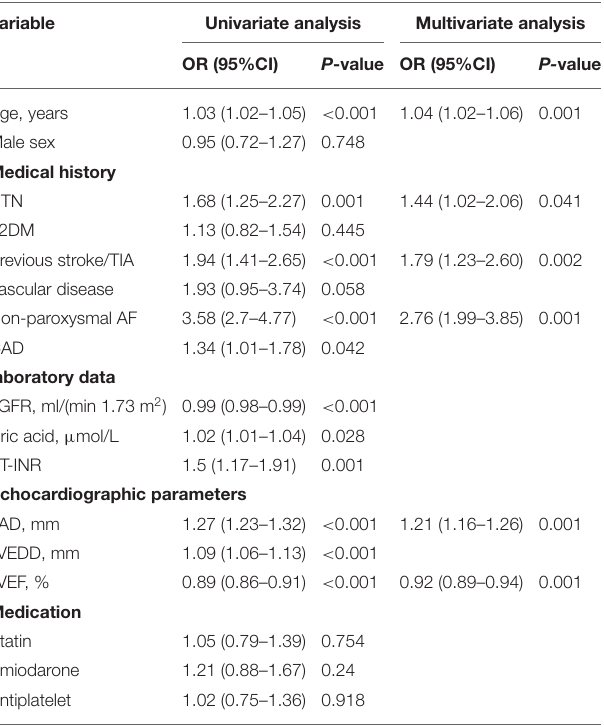
TABLE 2 | Univariate and multivariate logistic regression analysis of LAT/SEC presence based on peri-procedural data in the training cohort.